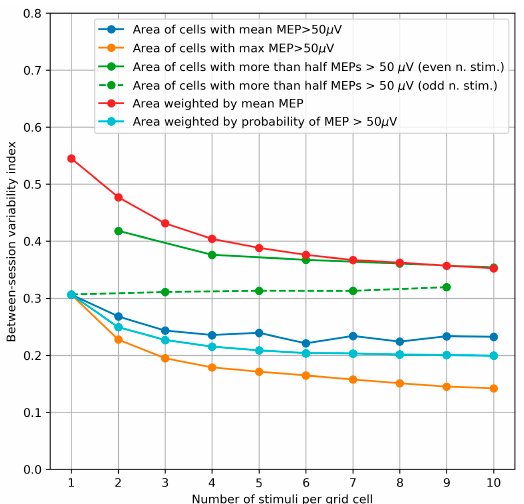
Figure 5. Between-session variability of the area parameters measured by an index equal to one-half of the relative difference of the maximum and minimum values among the three mapping sessions performed on consecutive days. These indices were calculated and averaged by 1000 triples of maps generated by bootstrapping from the MEPs obtained in the three sessions. The median values from all subjects are shown in the plot. The variability index significantly decreases with the number of stimuli per cell ( p < 0.001, Page’s trend test) for all the parameters except the area of the cells with more than half suprathreshold MEPs, which can have a non-monotonic, subject-dependent bias and should be interpreted with caution (see Appendix